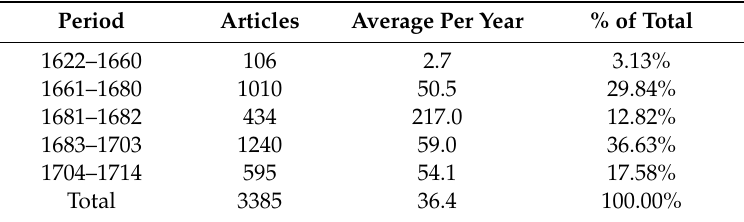
Table 1. Articles relating to the Maghreb by